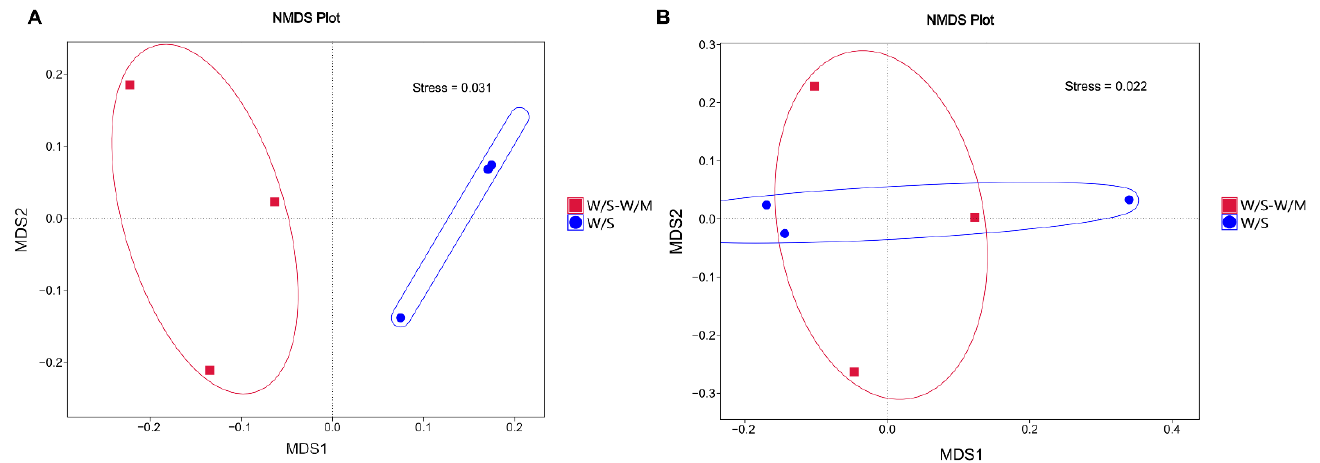
Figure 4. Non-metric multidimensional scaling (NMDS) analysis of rhizosphere soil fungi ( A ) and bacteria ( B ) in different cropping systems. W/S-W/M, wheat/soybean-wheat/maize rotation system; W/S, continuous wheat/soybean cropping system.